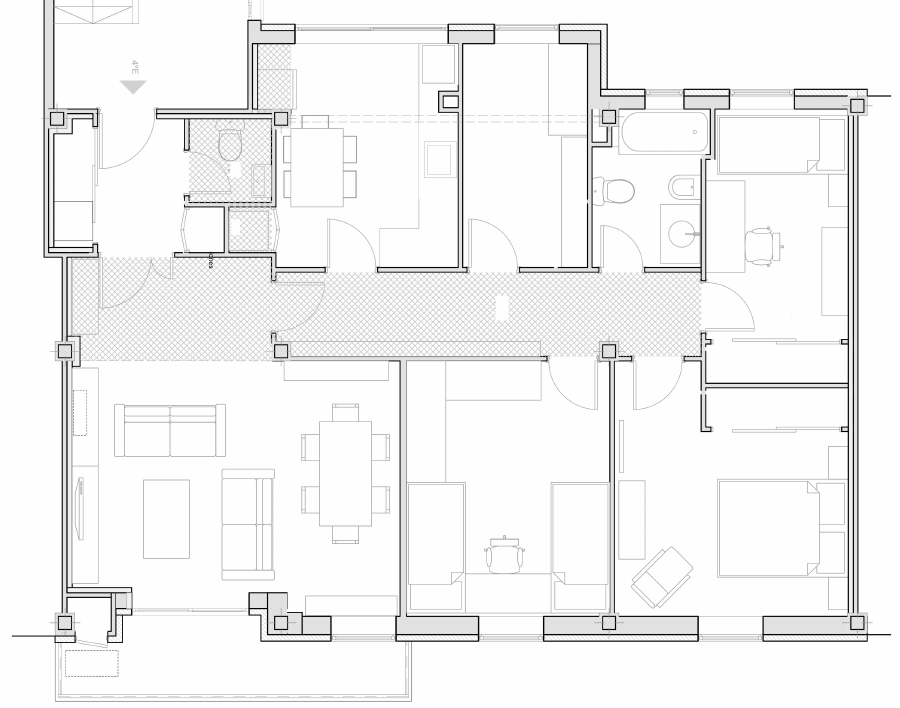
Figure 10. Dwelling floor